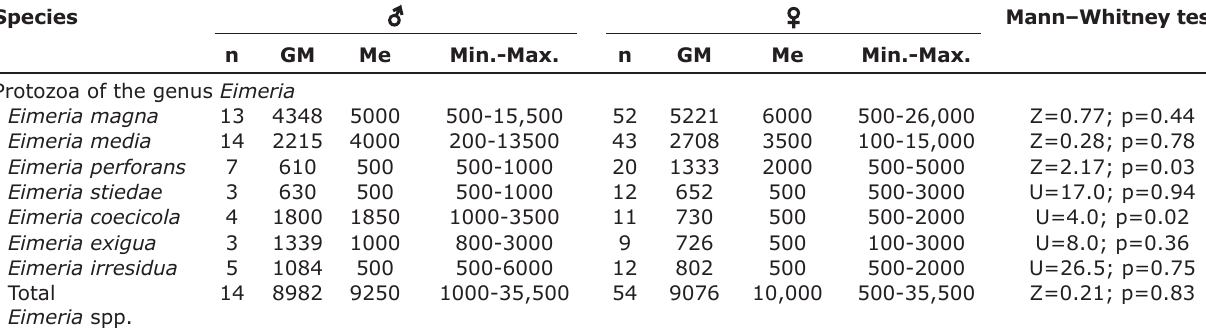
Table-2: Infection intensity (OPG) of rabbits with Eimeria spp. depending on gender. Species ♂ ♀ Mann–Whitney test n GM Me Min.-Max. n GM Me Min.-Max. Protozoa of the genus Eimeria Eimeria